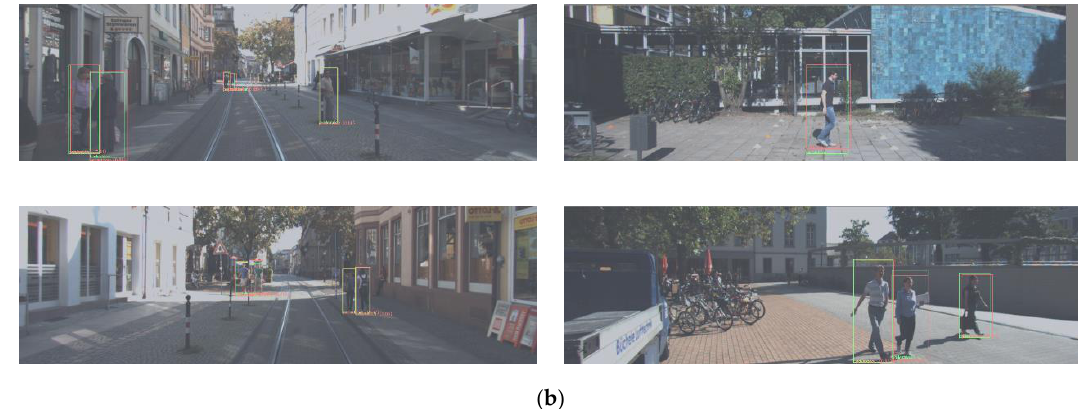
Figure 8. The detection results of images randomly selected for several situations. The green bounding box is the true value, and the red is the detection box. ( a ) Caltech–Zhang; ( b ) KITTI.